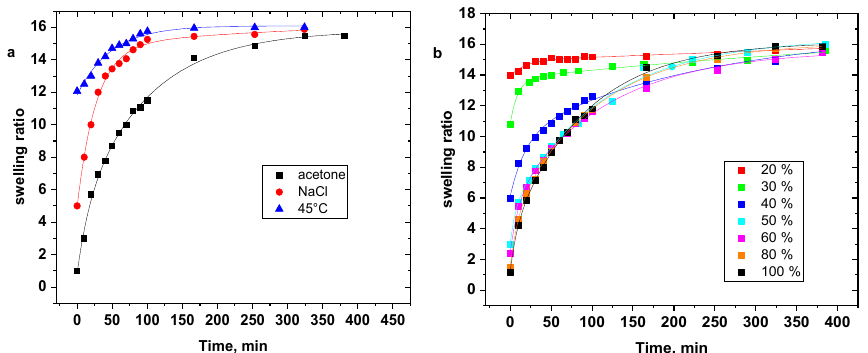
Figure 10. Swelling kinetic curves: time dependence of the swelling ratio of the DN-DA hydrogel swollen at 100 vol.% acetone, 6 M NaCl and pure water at 45 °C ( a ) and at water–acetone mixtures with various acetone contents ( b ) after immersion in 25 °C water. Experimental points are fitted using Equation (1).